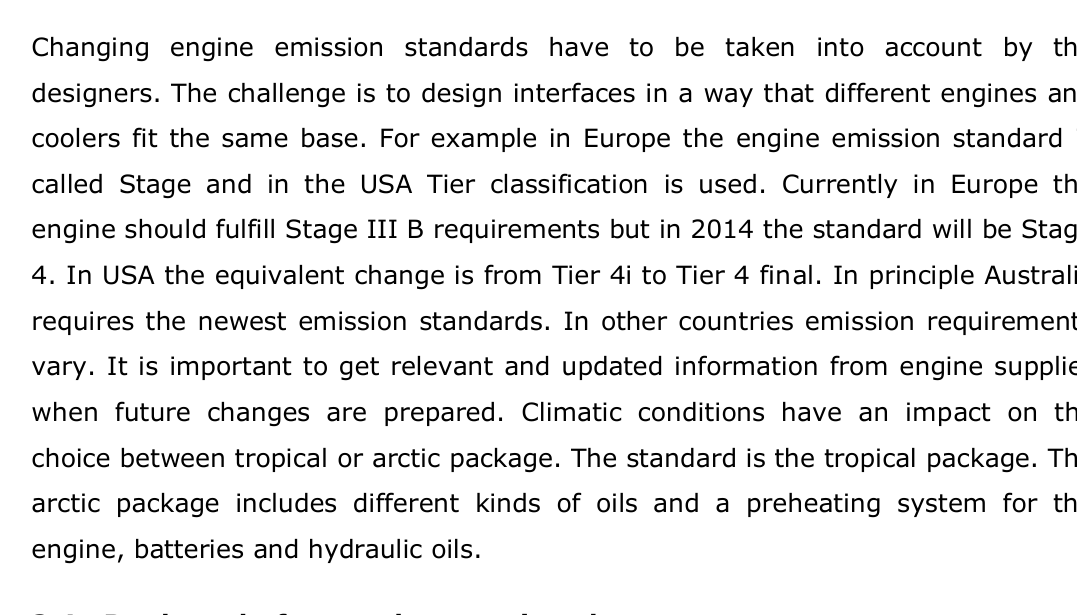
Figure 5. Segments and market tiers of the X-series